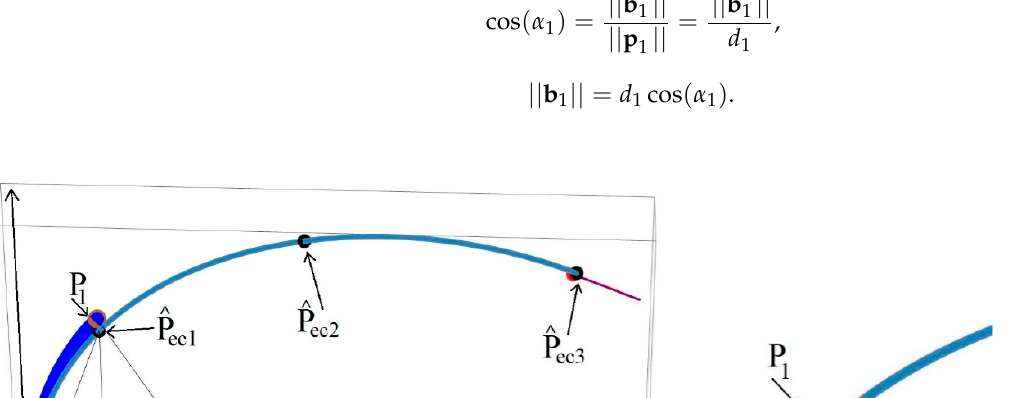
normalization and scaling to the new vector p : ( a ) vectors p and p with ec1 Nec1 ec1 Nec1 and p endpoints, zoomed in. ec1 Nec1